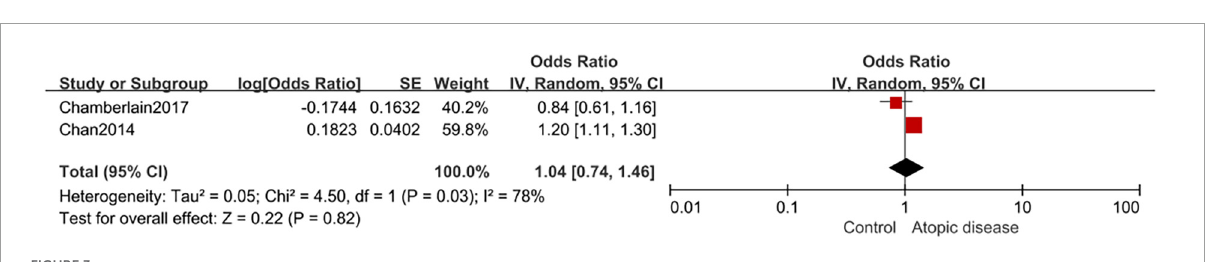
FIGURE3 Forest plot depicting the association of atopic diseases with AF risk in case-control studies (OR 1.04, 95% CI 0.74–1.46, I 2 =